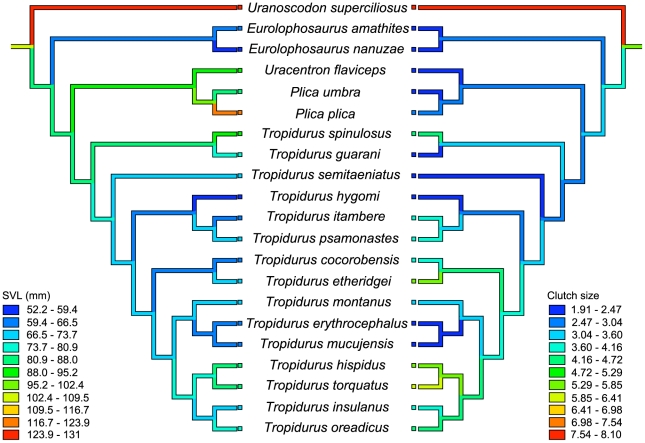
Topology of phylogenetic analysis and ancestral reconstruction of female body size and clutch size in the Tropidurinae.Topology used for phylogenetic analysis (based on [58]), together with parsimony reconstructions of ancestral body and clutch size in gravid females within Tropidurinae lizards.